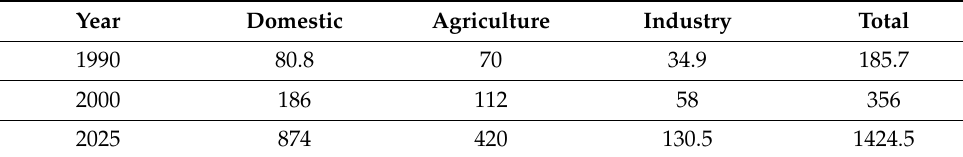
Table 3. Evolution of water withdrawal by section in DRC (million m 3